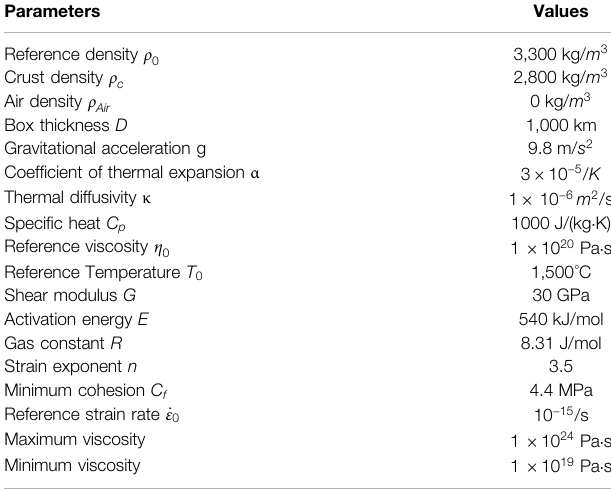
TABLE 1 | Physical parameters in the